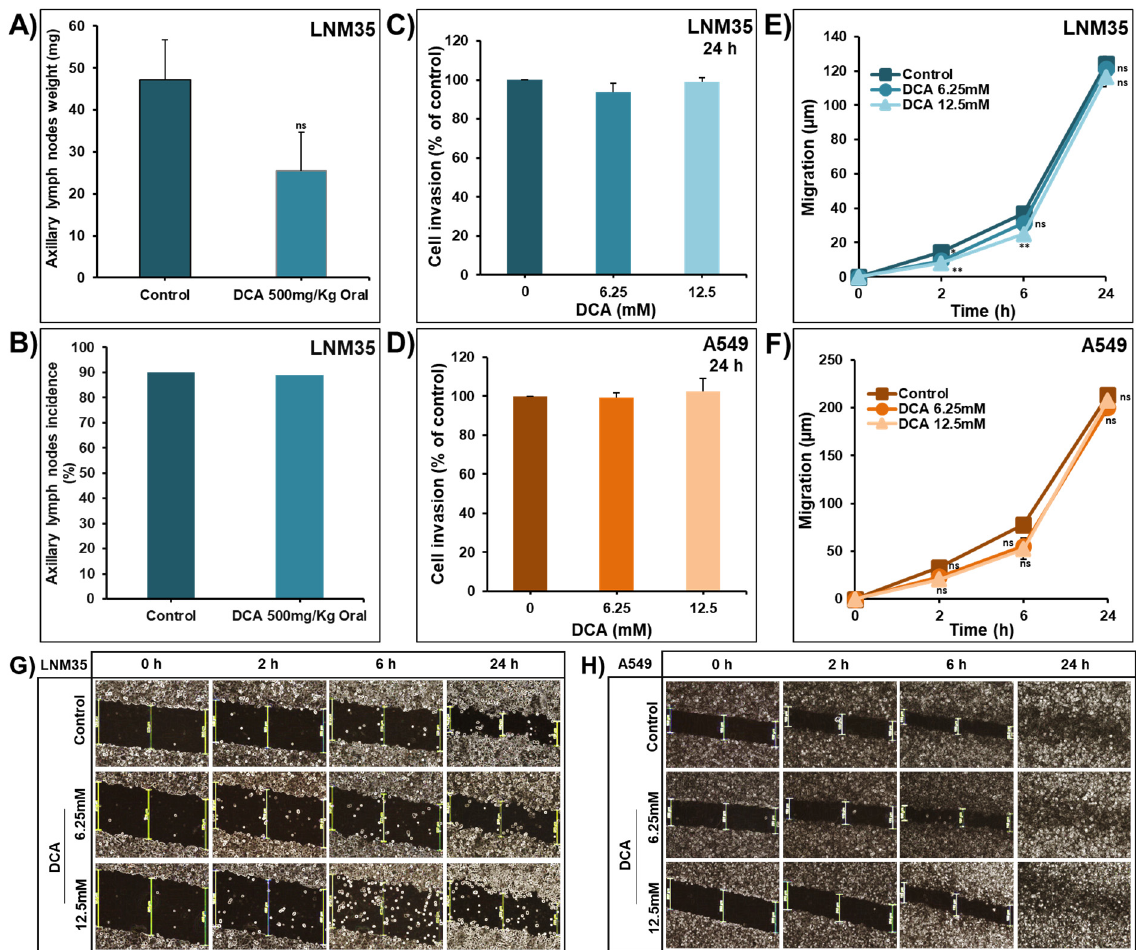
Figure 7. Effect of DCA on NSCLC metastasis in vivo and invasion and migration in vitro. ( A ) Weight of the axillary lymph nodes with LNM35 metastases in control and DCA-treated groups (500 mg/kg oral). ( B ) Percentage of mice with LNM35 lymph node metastases in control and DCA-treated groups. Results represent mean ± SEM of 9–10 mice/group. Using Boyden invasion chamber assay, LNM35 ( C ) and A549 ( D ) cells were incubated for 24 h in the absence and presence of DCA (6.25, 12.5 mM). Cells that invaded into the Matrigel and crossed the 8 µm pores were determined as described in the Materials and Methods. Scratches were introduced in confluent monolayers of LNM35 cells ( E ) and A549 cells ( F ) cultured in 6-well plate in the absence and presence of DCA (6.25, 12.5 mM). An inverted microscope with 4× magnification was used to measure the average distance that cells migrated from the edge of the scrapped area for 2, 6, and 24 h. Pictures of induced scratches in the confluent monolayers of LNM35 cells ( G ) and A549 cells ( H ) in the presence and absence of different concentrations of DCA at 0, 2, 6 and 24 h. All experiments were repeated at least 3 times. Columns or shapes are means; bars are S.E.M. * Significantly different at <0.05. ** Significantly different at <0.01. ns—non-significant.